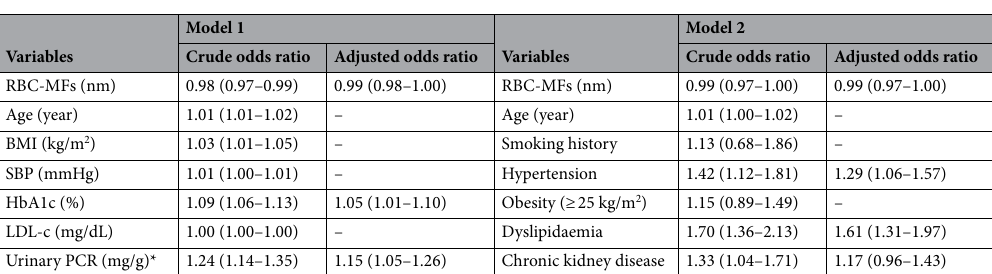
Table 3. Investigation of Independent Association of Clinical and Biochemical Parameters including Membrane Fluctuations of Red Blood Cells with Cardiovascular Disease. Data are expressed as adjusted odds ratios with 95% confidence intervals. Multivariable logistic regression analyses were performed by backward elimination method. Model 1 was tested in all participants. Model 2 was tested in diabetic patients. RBC-MF, red blood cell-membrane fluctuation; SBP, systolic blood pressure; LDL-c, low-density lipoprotein cholesterol; PCR, protein-to-creatinine ratio; BMI, body mass index. *Logarithmic-transformed value was used.